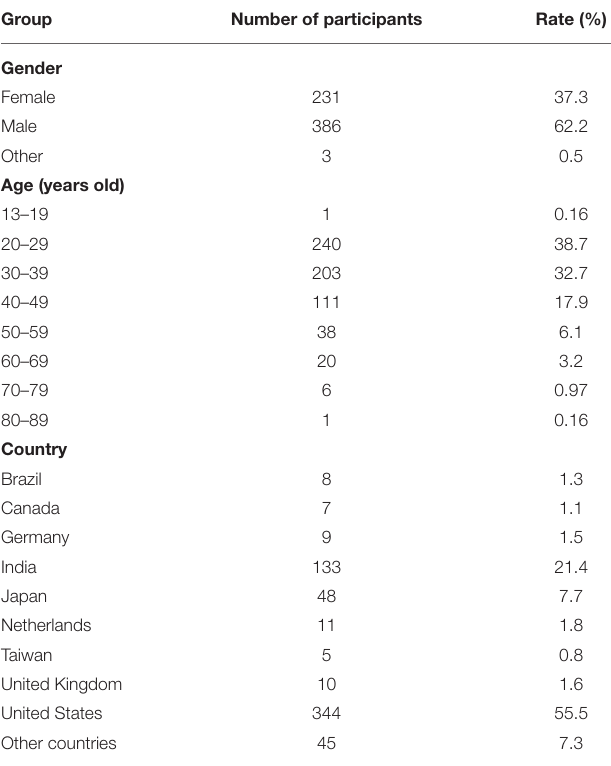
TABLE 2 | Gender, age, and country distributions of the responses.